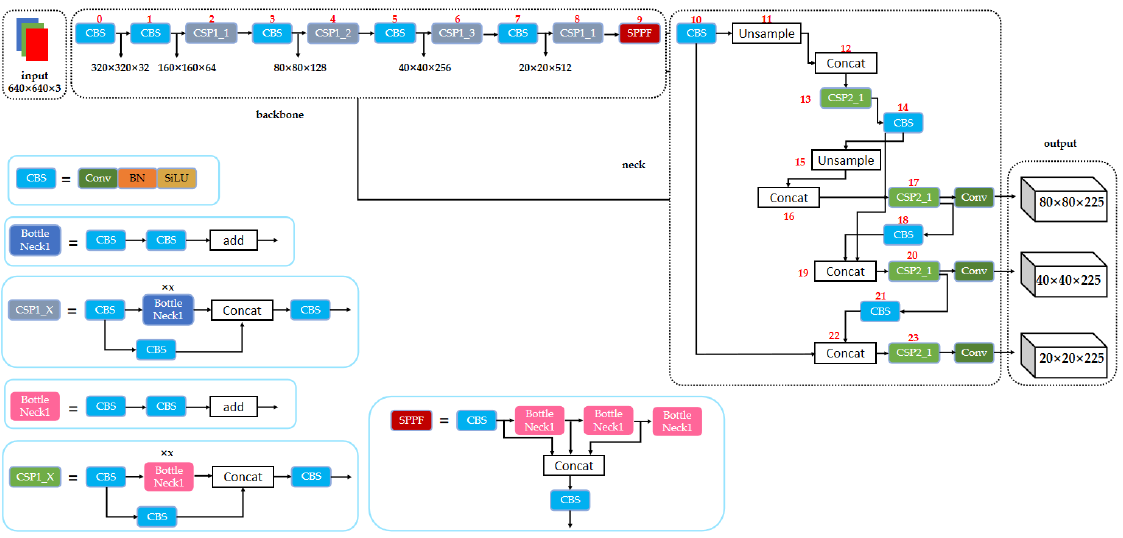
Figure 2. The structure of YOLOv5s. The numbers represent the modules needed to travel from the input image to the final output image. data augmentation, and adaptive anchor box calculation. Image resizing allows